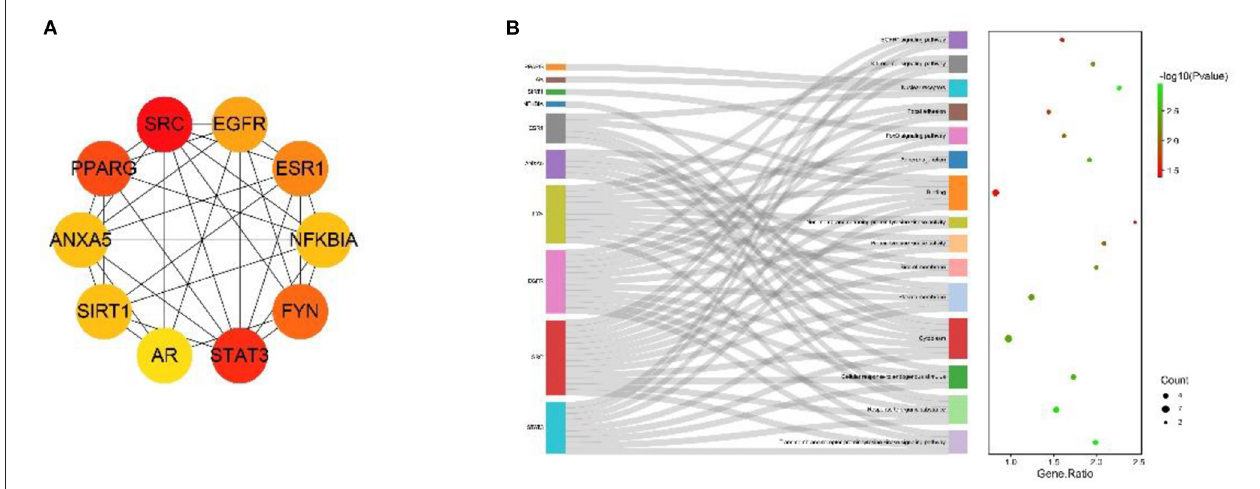
FIGURE 6 | The screened Hubba genes and the results of their enrichment analysis. (A) The 10 central genes identified from the PPI network. Circles represent target proteins, with darker colors indicating higher MNC scores and greater importance in intersecting target proteins. (B) The first 3 GO terms and KEGG pathways for the 10 Hubba genes. The sankey diagram represents the correspondence between the top 10 genes according to the MNC score (left) and the enriched GO function and KEGG pathway (right). The circles in the bubble diagram represent functional descriptions, the shade of color indicates the size of the P -value, and the size of the diameter indicates the number of intersecting targets present in the current GO function or KEGG